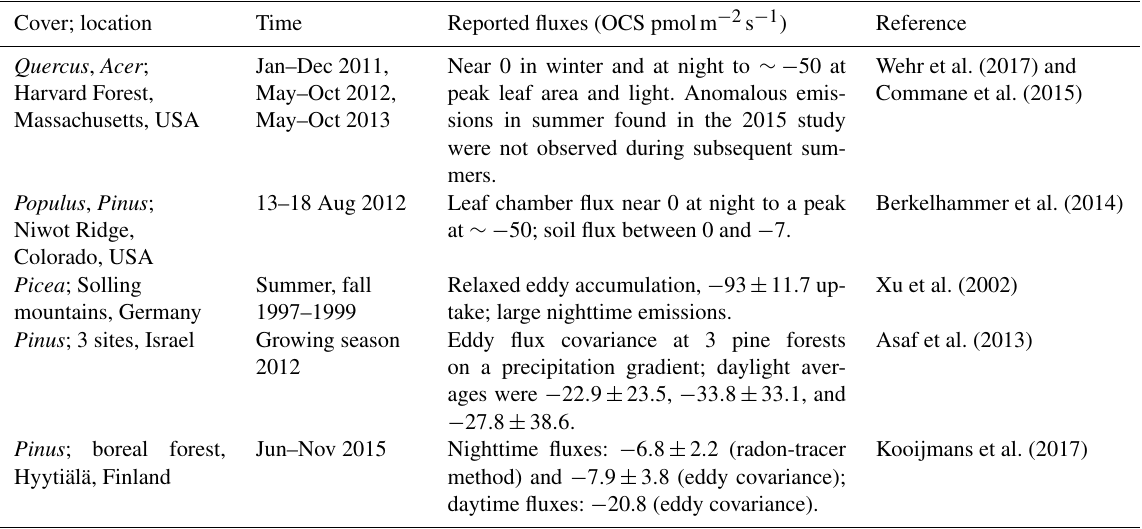
Table 1. In situ fluxes of forest ecosystems. Some of these data are plotted in Fig. 2. Cover;